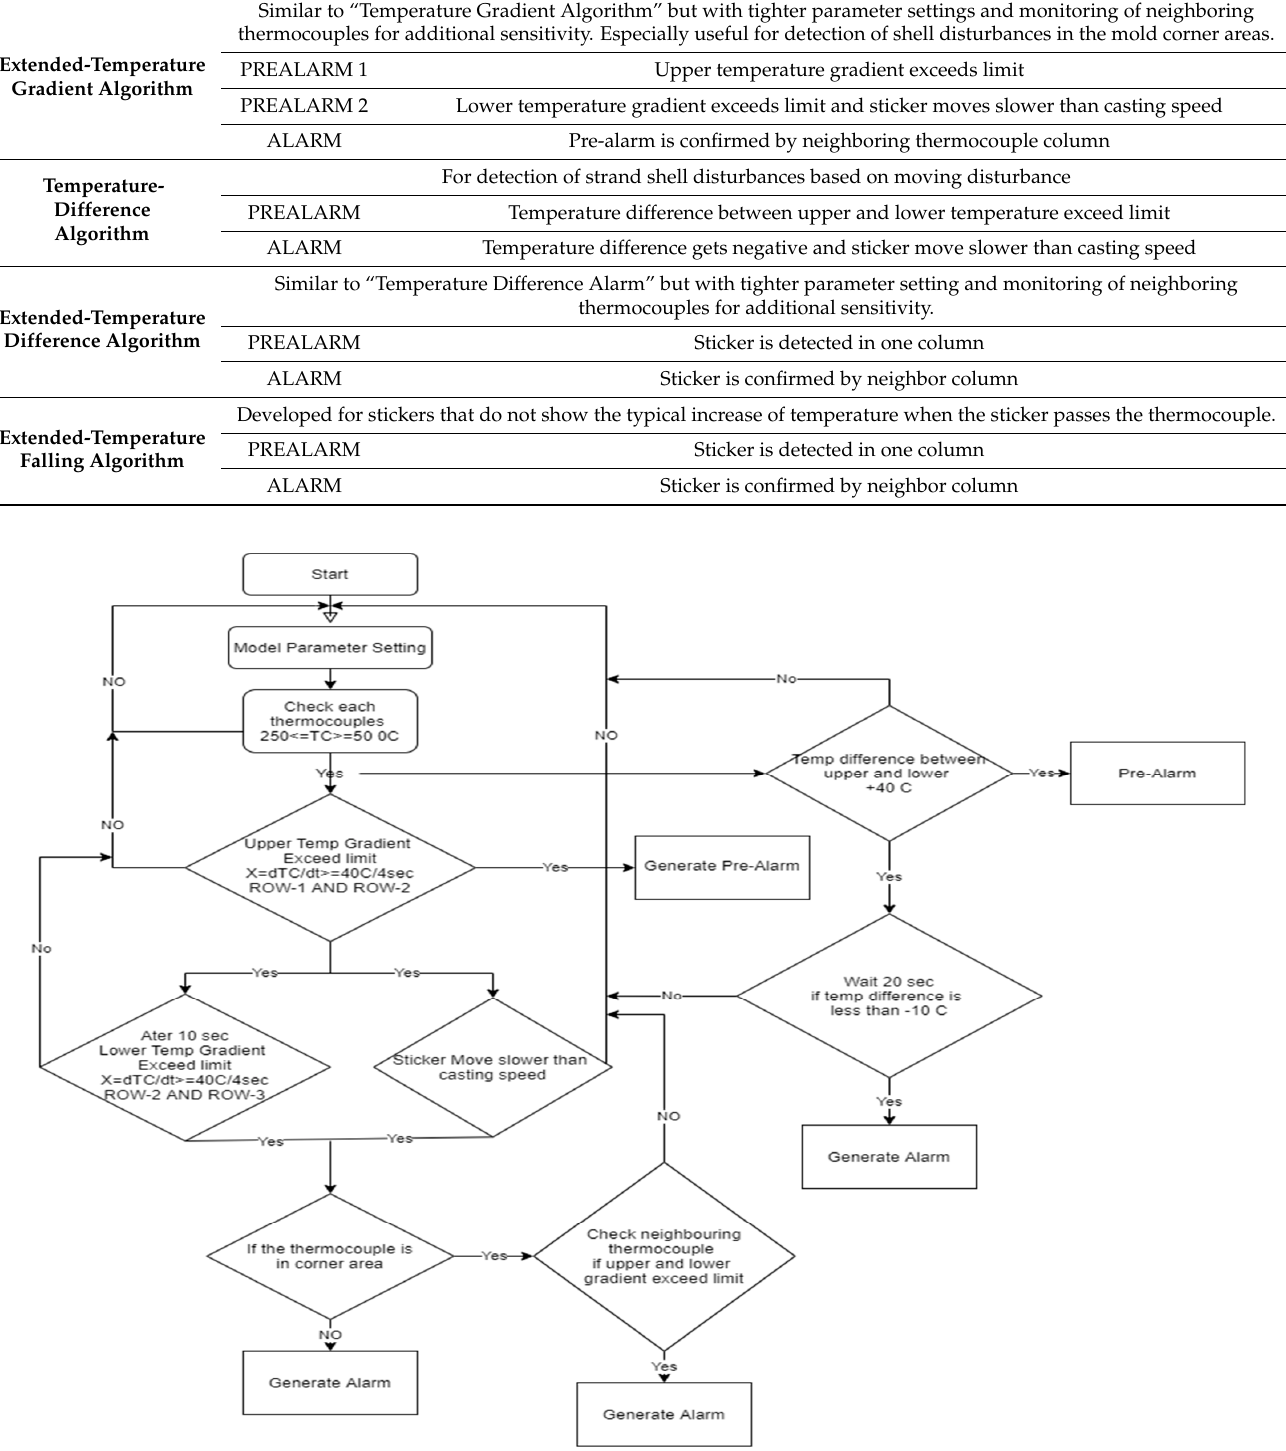
Figure 8. New logic ‐ based model for sticker breakout prediction. Figure 8. New logic-based model for sticker breakout